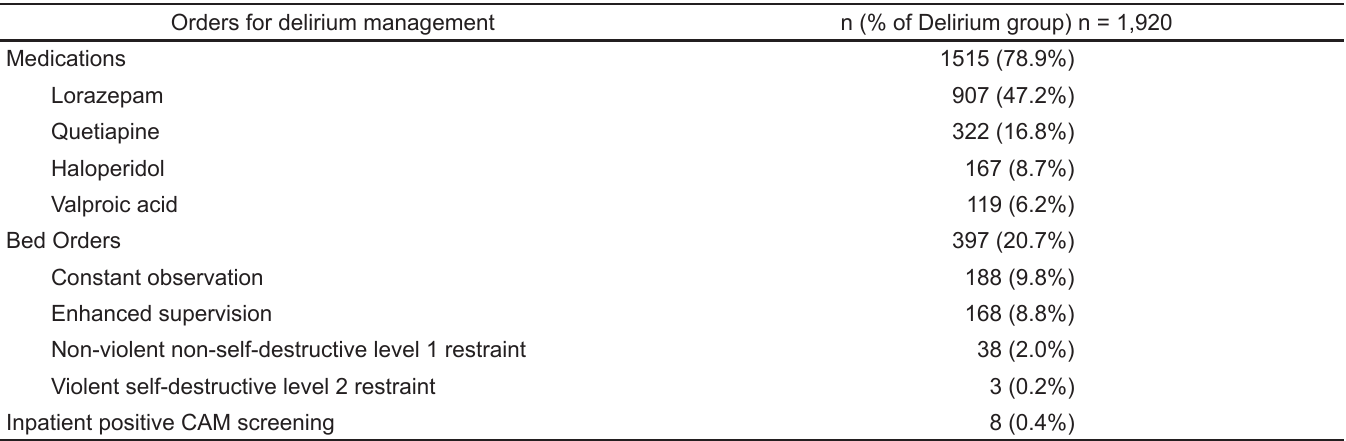
Table 3. Medications and orders used for delirium identification.